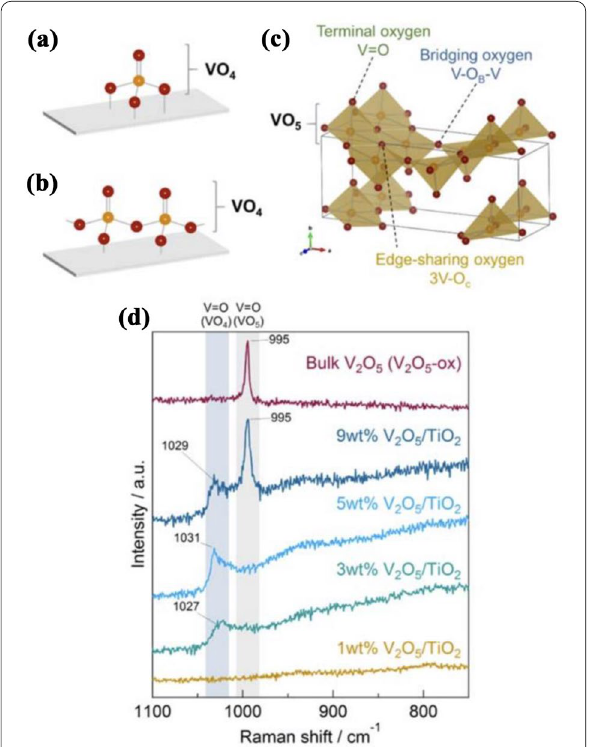
Fig. 8 Structures of the dehydrated surface vanadate phases on TiO 2 : a isolated mono‑oxo VO 4 , b oligomeric mono‑oxo VO 4 , and c crystalline V 2 O 5 nanoparticles on top of the surface vanadate monolayer